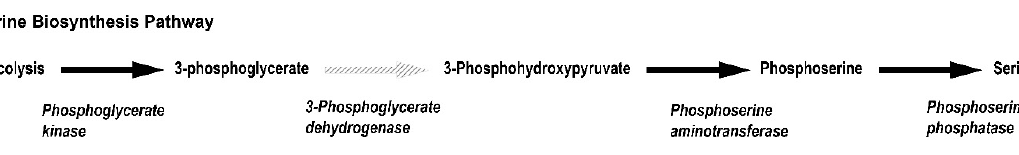
Figure 1. Pathway depicting serine biosynthesis from glycolysis. Metabolic intermediates involved in the enzymatic synthesis of L-serine from glycolysis is shown here with the rate limiting step marked with a dashed grey arrow. The enzymes involved in respective steps are shown in bold italics below the arrow for the individual reaction.